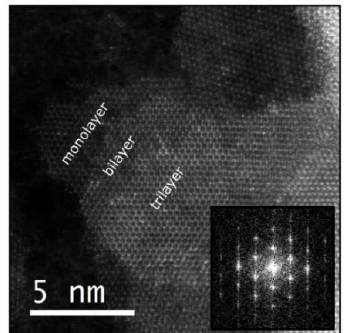
Figure 4. High-magnification HAADF images of a MoS 2 thin film transferred over a holey Si 3 N 4 membrane support. Inset shows FFT where a clearly hexagonal symmetry is exhibited.